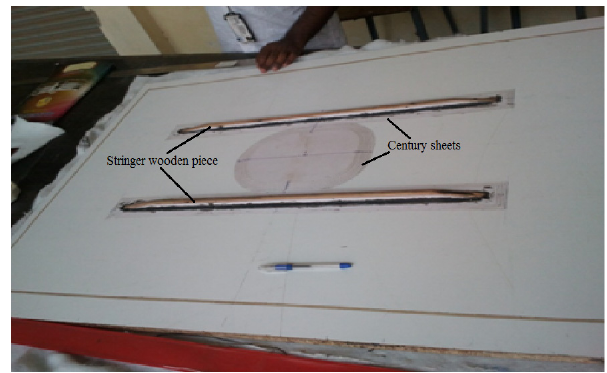
Figure 2. Tool for making caul plate.